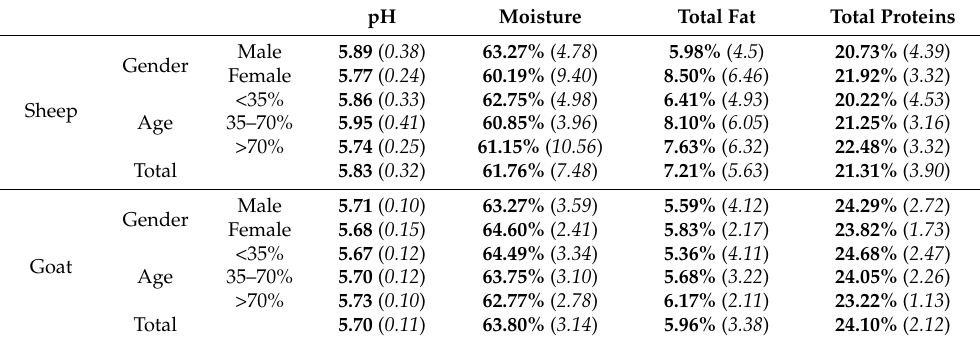
Table 4. Physicochemical analyses of sheep and goat carcasses, based on gender and age (average in bold, standard deviation in parentheses and